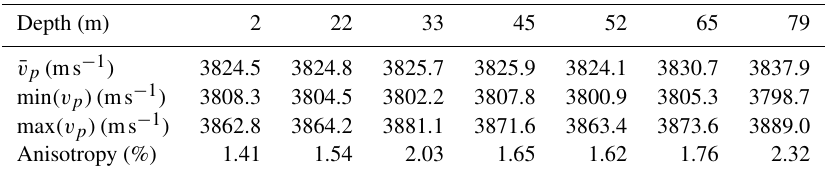
Figure 3. Mean values for measured and calculated seismic velocities for (a) vertical, i.e. ϕ = 0 ◦ , and (b) horizontal, i.e. ϕ = 90 ◦ , directions along the ice core. The shaded areas show the standard deviations of the respective measurements. The dashed blue lines show the respective COF-derived velocities without porosity correction. Table 1. Mean, minimum, and maximum calculated P wave velocities (i.e. derived from the COF pattern and not from ultrasonic experiments, without air correction) and degree of anisotropy for each COF